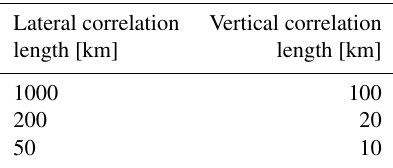
Table 1. Lateral and vertical correlation lengths of random medium variations used to assess the influence of medium